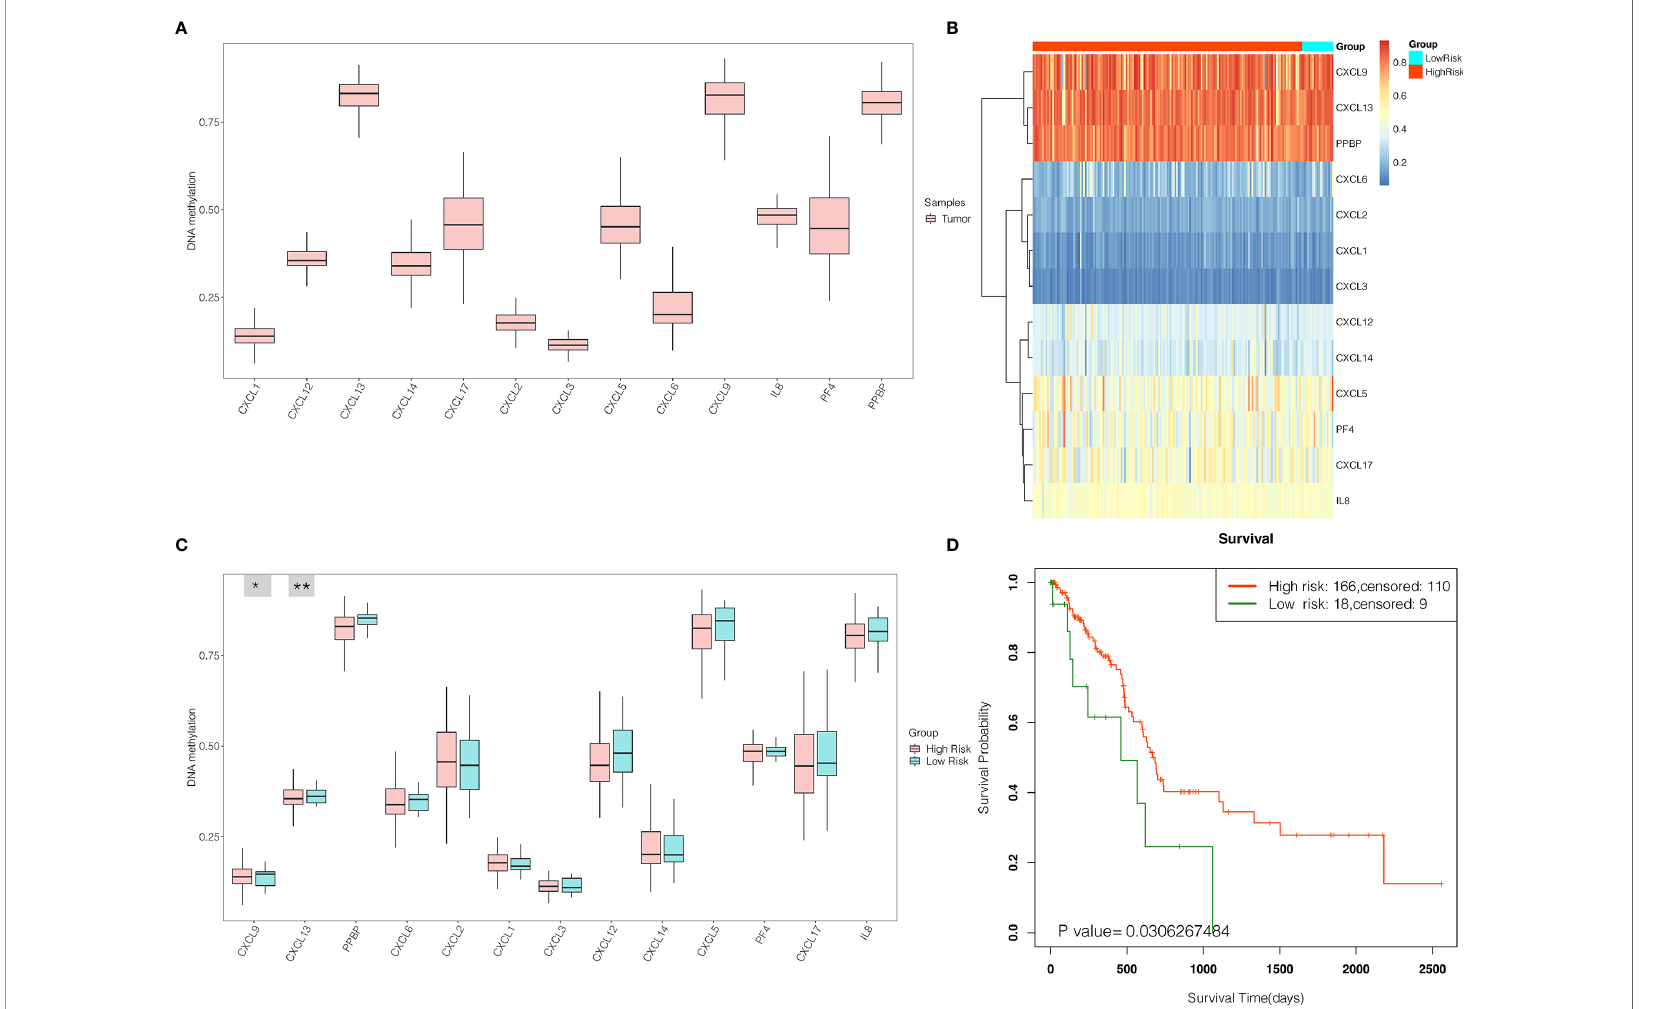
FIGURE 12 | The expression levels and prognostic values of the DNA methylation of CXC chemokine signature in patients with PAAD (SurvivalMeth). (A) The DNA methylation level of single CXC chemokine in PAAD patients. (B) The heatmap of DNA methylation of CXC chemokines in PAAD patients in high- and low-risk groups. (C) The expression levels of DNA methylation of CXC chemokines between high- and low- risk groups. * p < 0.05; ** p < 0.01. (D) Kaplan – Meier curves for survival analysis of DNA methylation of CXC chemokines between high- and low-risk